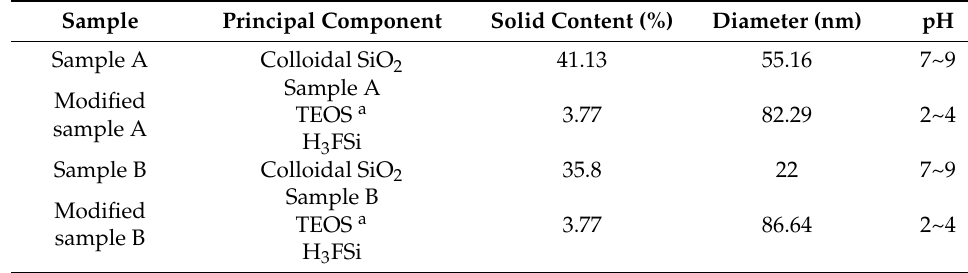
Table 1. The chemical properties of unmodified and modified